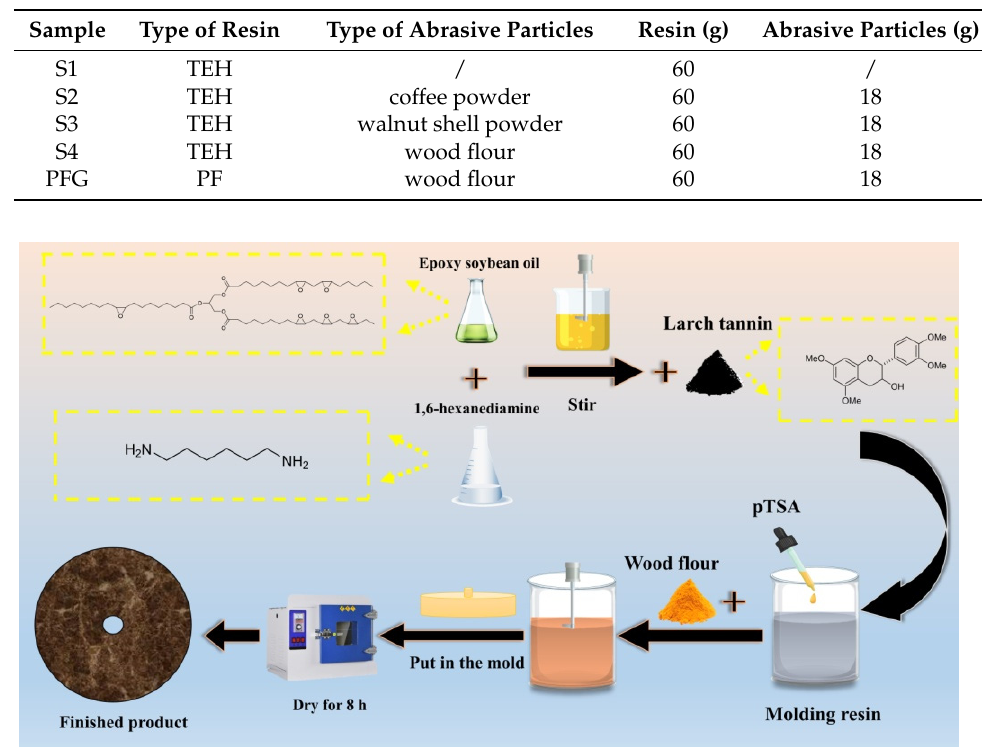
Table 1. Formulations of the various grinding wheels.